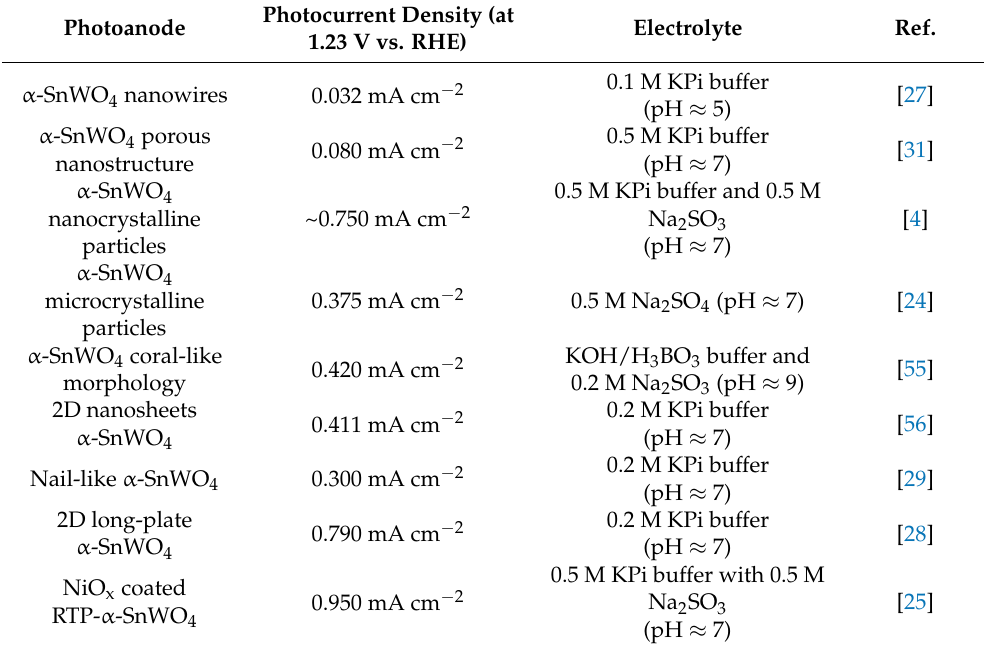
Table 2. Recent report on the performance of α -SnWO 4 based photoanodes in PEC water splitting.